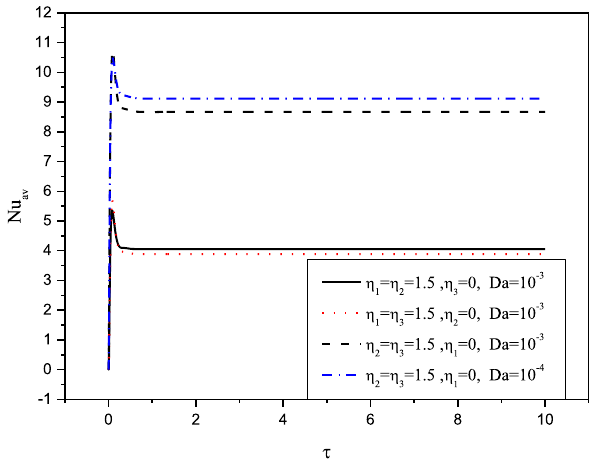
Figure 8. Profiles of the average Nusselt Number for the variations of ( (η 1 , η 2 , η 3 and Da ) at 10, Ra 10 6 , Ha 10, α 0.1, D 10, δ 0.4, φ 0.02 . Ha S = d = av = = = = =